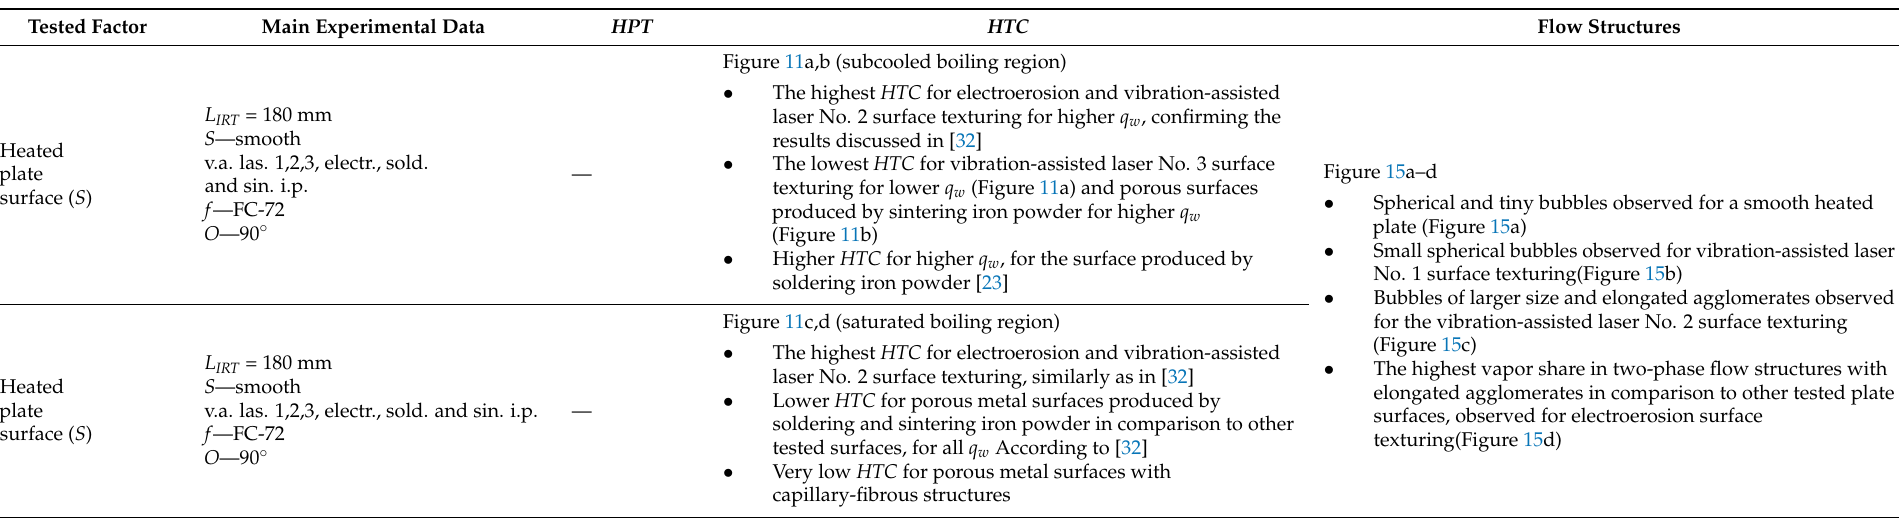
Figure 11a,b (subcooled boiling region)